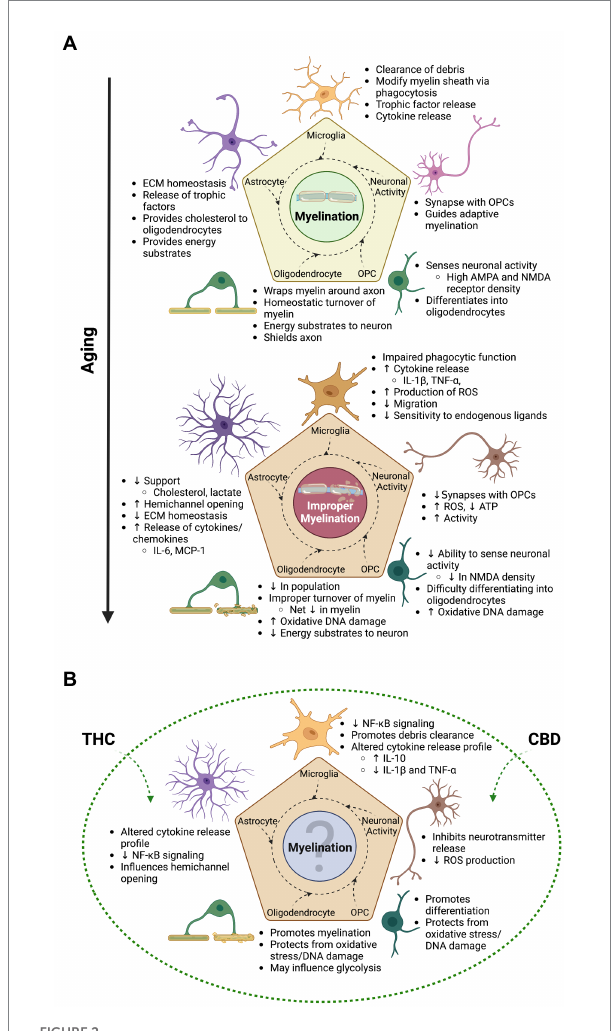
FIGURE 2 The transitional relationship between myelination and aging and the possible therapeutic advantage of cannabinoids | As emphasized throughout this review, the process of myelination is an intricate undertaking that involves all glial cells in the brain and is mainly driven by experience induced neuronal activity in adulthood and during aging. (A) The top panel of this figure shows some of the general contributions glial cells and neurons make to the overall process of myelination. With increasing age, a switch in cell state takes place in glial cells and neurons, ultimately leading to improper myelination and impairments in cognition. (B) The bottom panel showcases some of the benefits that cannabis (mainly focusing on THC and CBD) can have on myelination, as found in animal studies; with the majority looking at younger time points. Although evidence suggests improved myelination and cognition from cannabis use in aging animals, the paucity of studies focusing on this time point translates to relatively unknown overall effects of cannabis on myelination. This question mark indicates that topic, which is in need of increased research. Not only will this help fill in the gap of knowledge as to how cannabis impacts myelination across the lifespan, but will also better inform researchers on the effects of the endocannabinoid system on the aged brain. With this understanding, we are also better able to inform the public and health authorities on the impact cannabis use has on the senior population, who at the moment show increasing levels of consumption. Created with